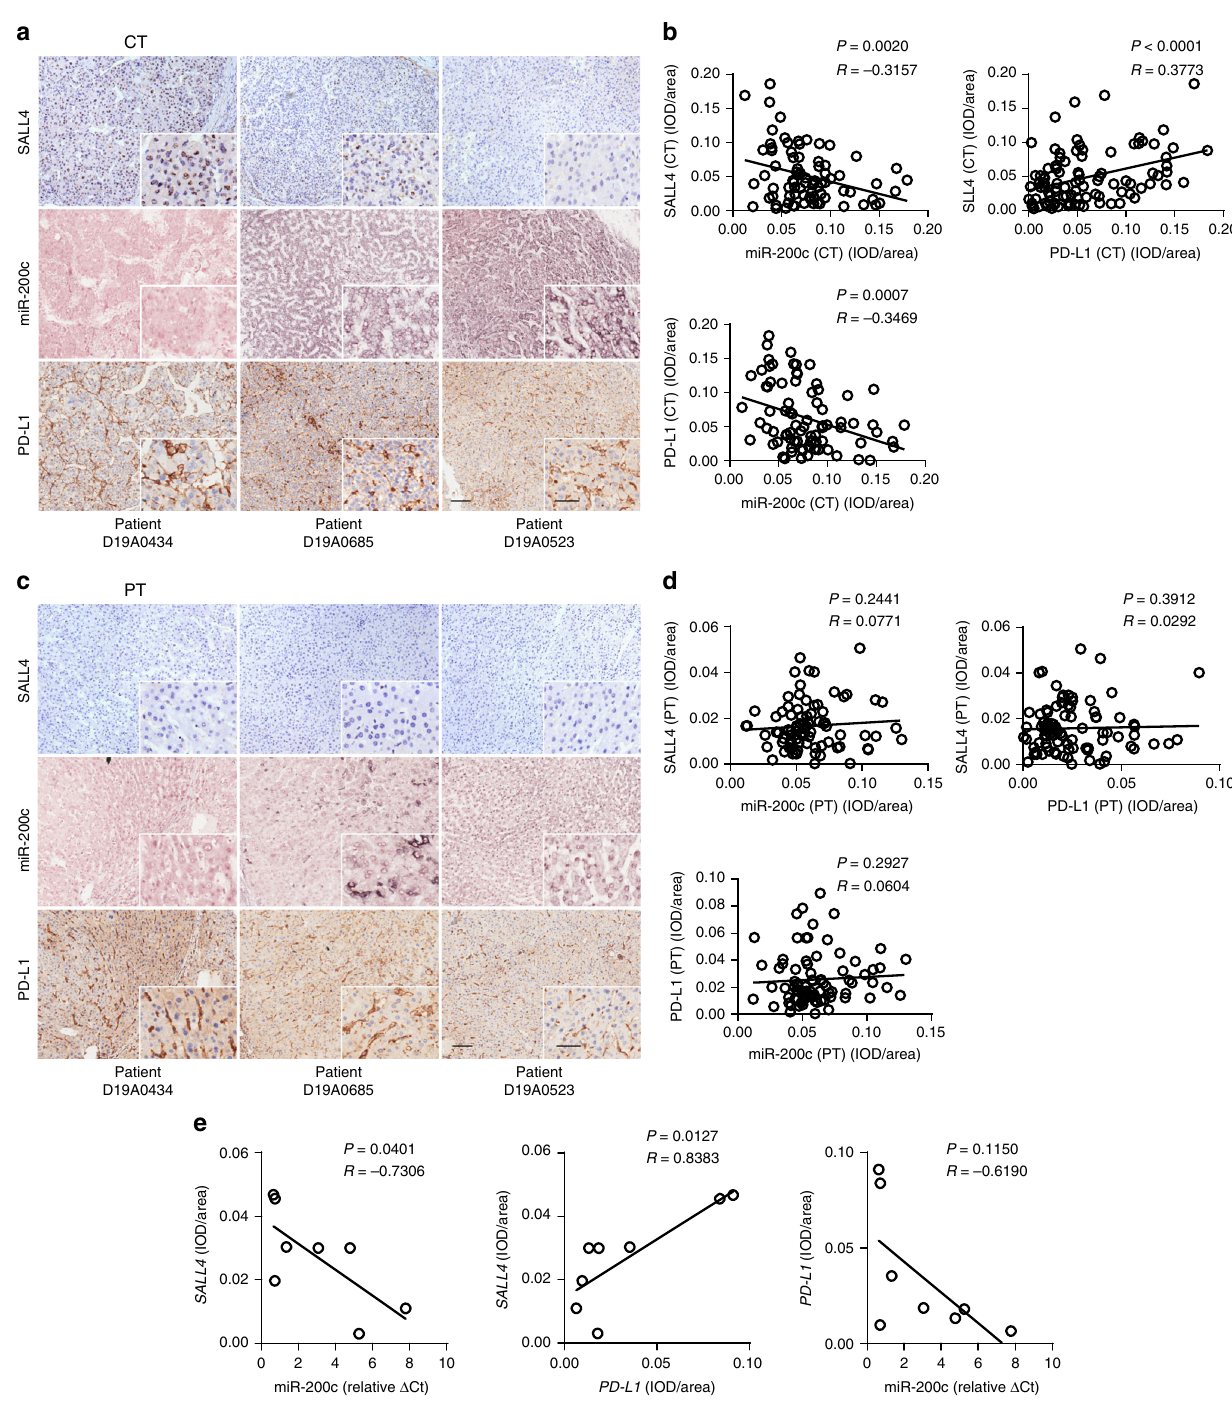
Fig. 2 Correlations among SALL4, miR-200c, and PD-L1 in the center tumor regions of HCC. a , c Immunostaining of SALL4 and PD-L1 proteins and miR- 200c in situ hybridization in the center tumor a and peritumor c regions of three representative HCC patients. Original magni fi cations: × 10, × 20; bar = 100 µ m, 50 µ m, respectively. b , d Pearson correlation analysis between the expression (IOD/area) of SALL4, PD-L1 and miR-200c in center tumor ( b ) and peritumor ( d ) regions of HCC. e Correlation analysis between SALL4 and miR-200c (Relative Δ Ct) (left), SALL4 and PD-L1 (middle), and PD-L1 and miR-200c (right), from eight fresh tissue HCC samples. Spearman ’ s correlation coef fi cients and P values are regions ( P = 0.2441, R = -0.3157, Pearson ’ s correlation coef fi cients) or miR-200c and P = 0.3921, R = 0.0292, Pearson ’ s correlation coef fi cients) PD-L1 ( P = 0.0007, R = -0.3469, Pearson ’ s correlation coef fi - (Fig. 2c, d). To further verify these two pairs of negative cients), accompanied with a positive correlation between SALL4 correlation between SALL4 and miR-200c or miR-200c and and PD-L1 expression ( P < 0.0001, R = 0.3773, Pearson ’ s correla- PD-L1, we investigated the expressions of miR-200c utilizing (Fig. 2b); however, no statistical q-RT-PCR on eight fresh HCC samples. As expected, we correlation among these molecules was identi fi ed in peritumor